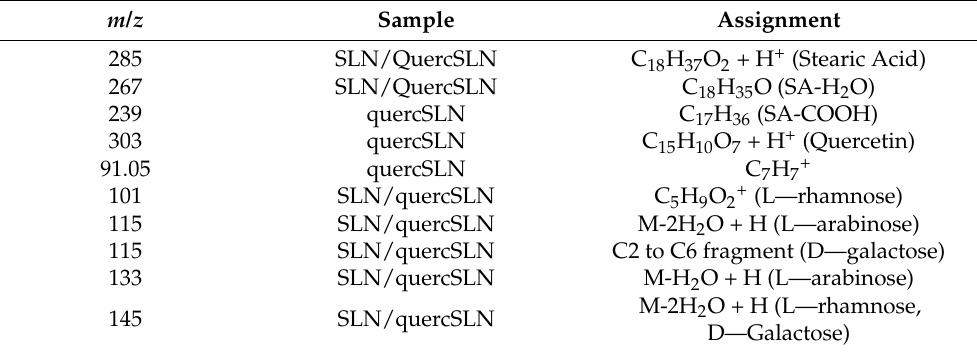
Table 4. Mass peaks assignment. Molecular ions are